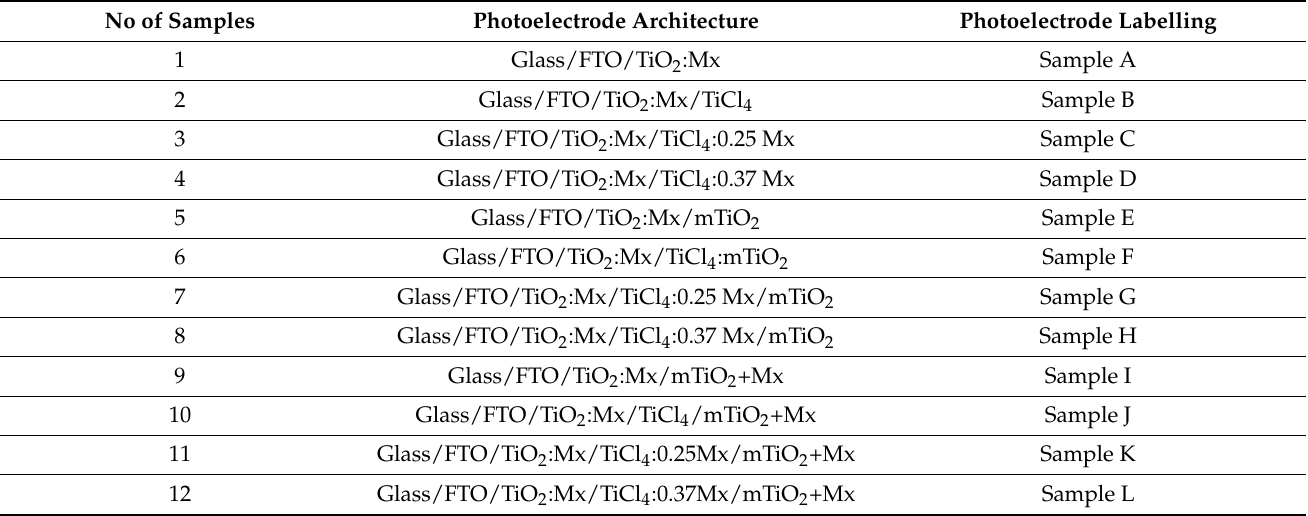
Table 1. List of the compositions of all prepared